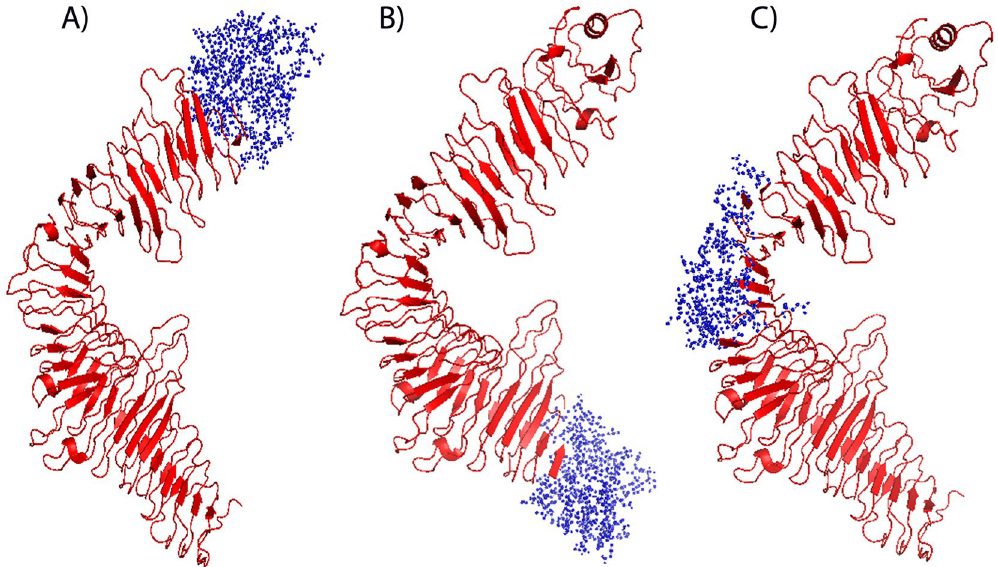
Figure 3. 3D representation of conformational B-cell epitopes ( A – C ) of protein. The predicted epitope residues are denoted by blue colour (ball & stick), and the rest of the residues are in red